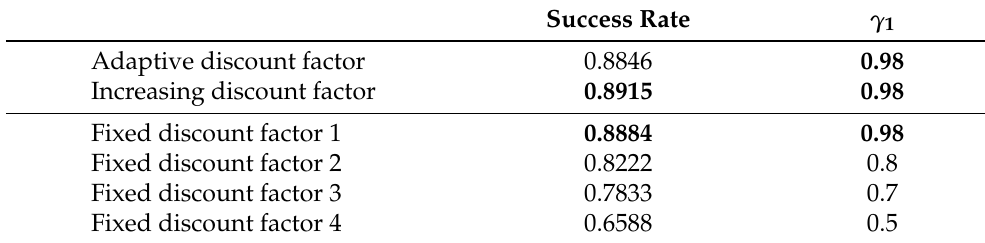
Table 3. Comparison of success rate in episodic path planning task.